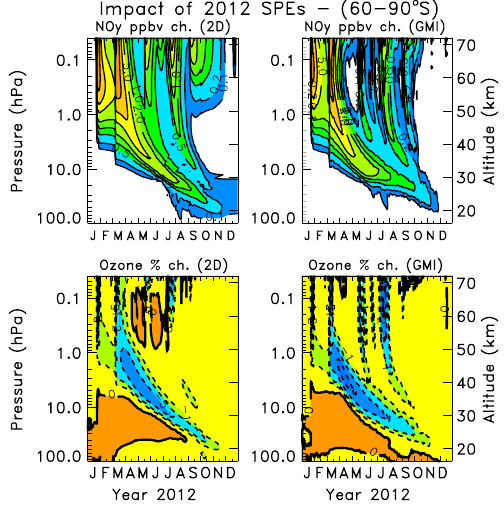
Fig. 12. ( Left ) Difference between GSFC 2-D model simulation “B (with SPEs)” and “A (without SPEs)”. ( Right ) Difference be- tween GMI 3-D CTM simulation “D (with SPEs)” and “C (without SPEs)”. NO y ( Top ) and Ozone ( Bottom ) for 60–90 ◦ S are given for all months of 2012. The contour intervals for the NO y differences are 0.1, 0.2, 0.5, 1, 2, 5, 10, and 20ppbv. The contour intervals for the Ozone differences are − 20, − 10, − 5, − 2, − 1, and